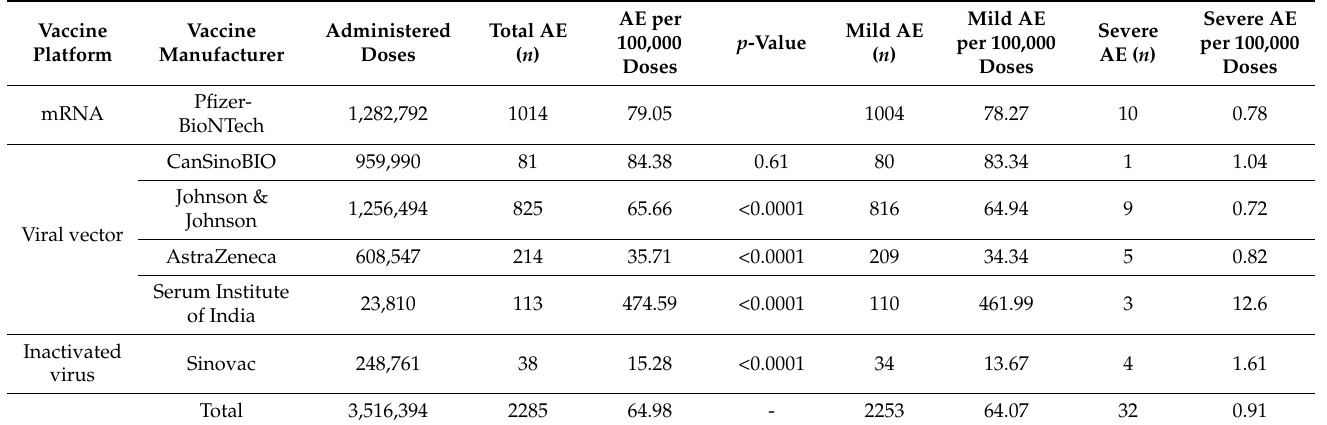
Table 1. Mild, severe, and total adverse events per 100,000 administered doses by vaccine manufac-